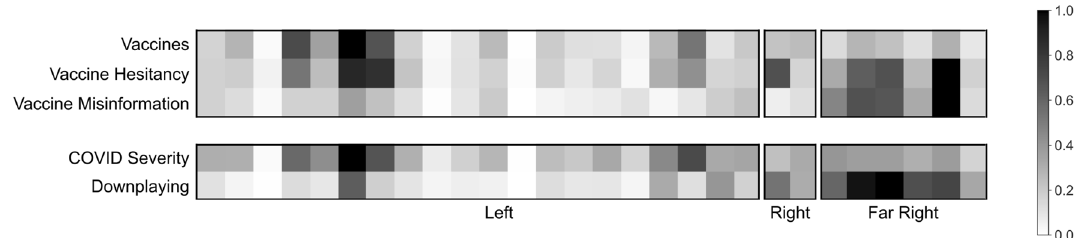
related phrases. Figure 3 compares tweet rates between communities for tweets concerning vaccines, vaccine hesitancy, vac-